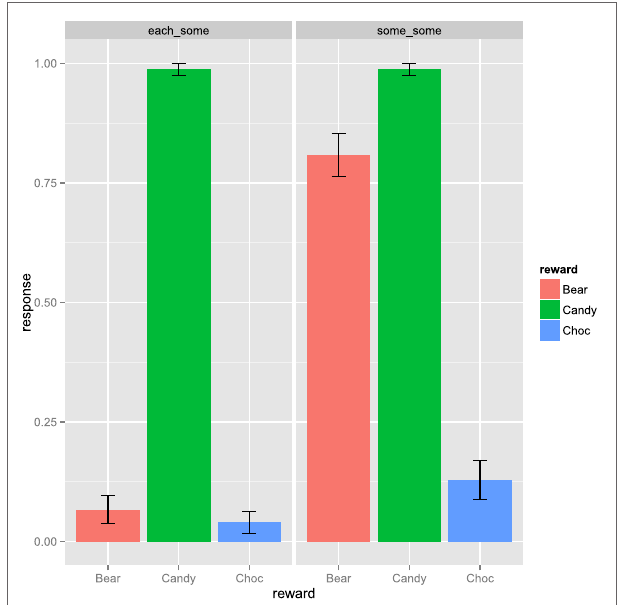
FigUre 1 | Experiment 1: % YES responses for sentence (25)-a ( each- some , left column) and (25)-b ( some-some , right column). The colors mark different reward types (gummy bears “none” = red, candy “some” = green, chocolate “all” = blue). Error bars represent SEM.